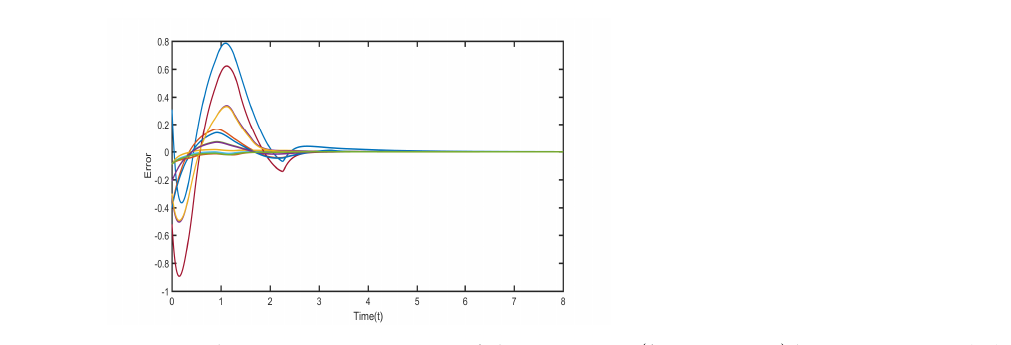
Figure 8. The error state trajectories of cluster one i.e., ( h = 1, i = 1,2 ) between CVNNs (23) and (24).